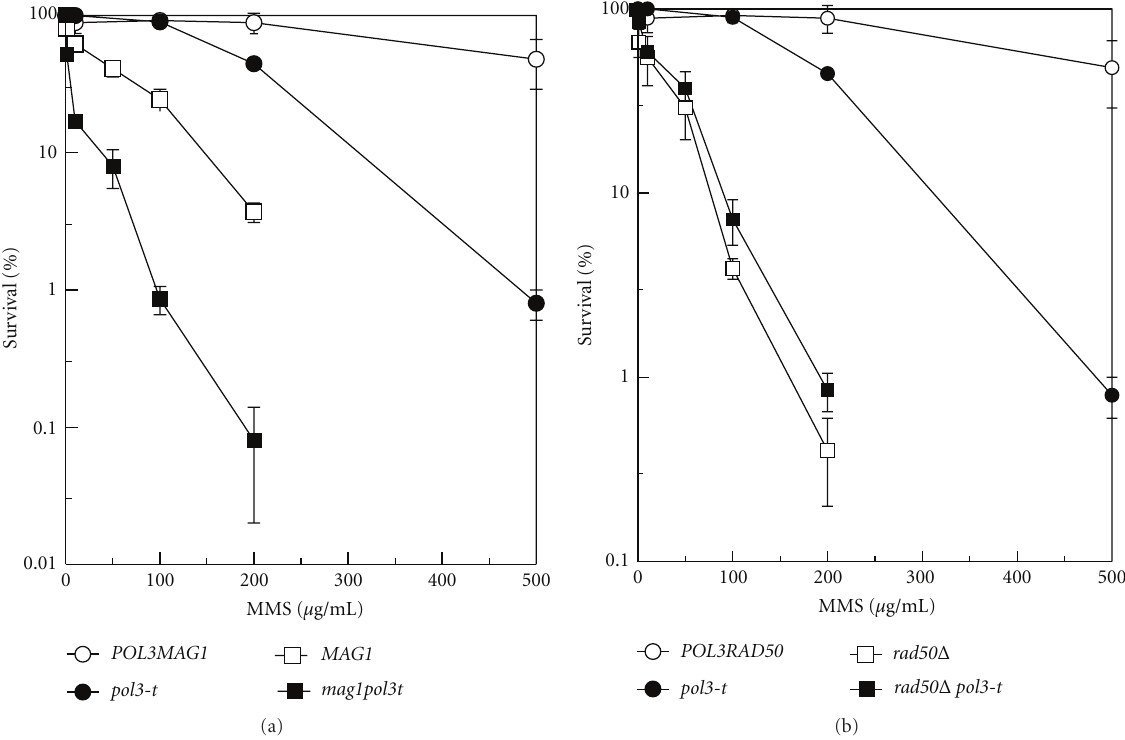
Figure 1: Epistasis interaction between mag1 Δ and pol3-t (a); and rad50 Δ and pol3-t (b). All strains were isogenic to RSY6. Single colonies of each strain were pregrown at 25 ◦ C for 24 hours and exposed to MMS for 4 hours at 30 ◦ C as reported in the materials and methods. Data are reported as the mean of six or more independent experiments ± standard